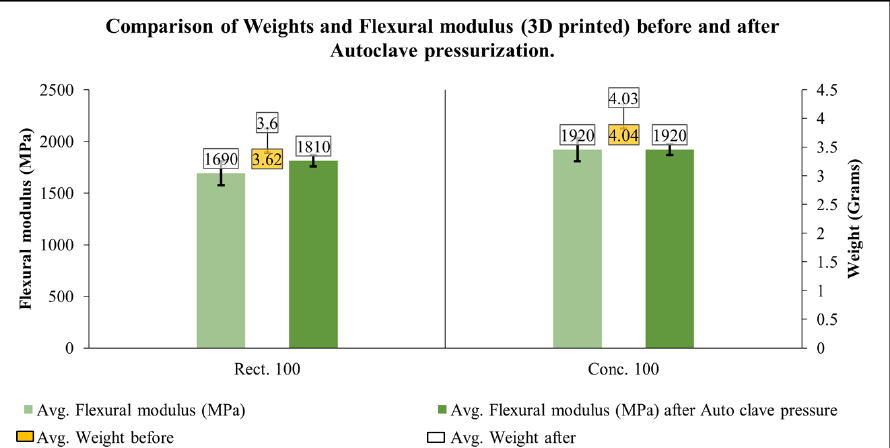
Figure 17. Showing comparison between weights and flexural modulus of PLA 3D-printed samples before and after autoclave pressurization